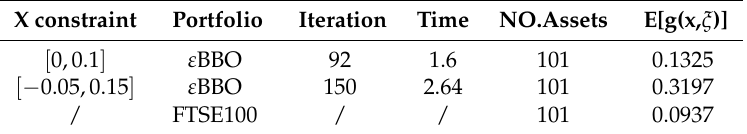
Table 4. The model (30) using date of 249 daily historical returns of 101 FTSE100 assets prior to December 2016. Time is in minute and the expected return of the benchmark portfolio E [ g ( y , ξ )] =